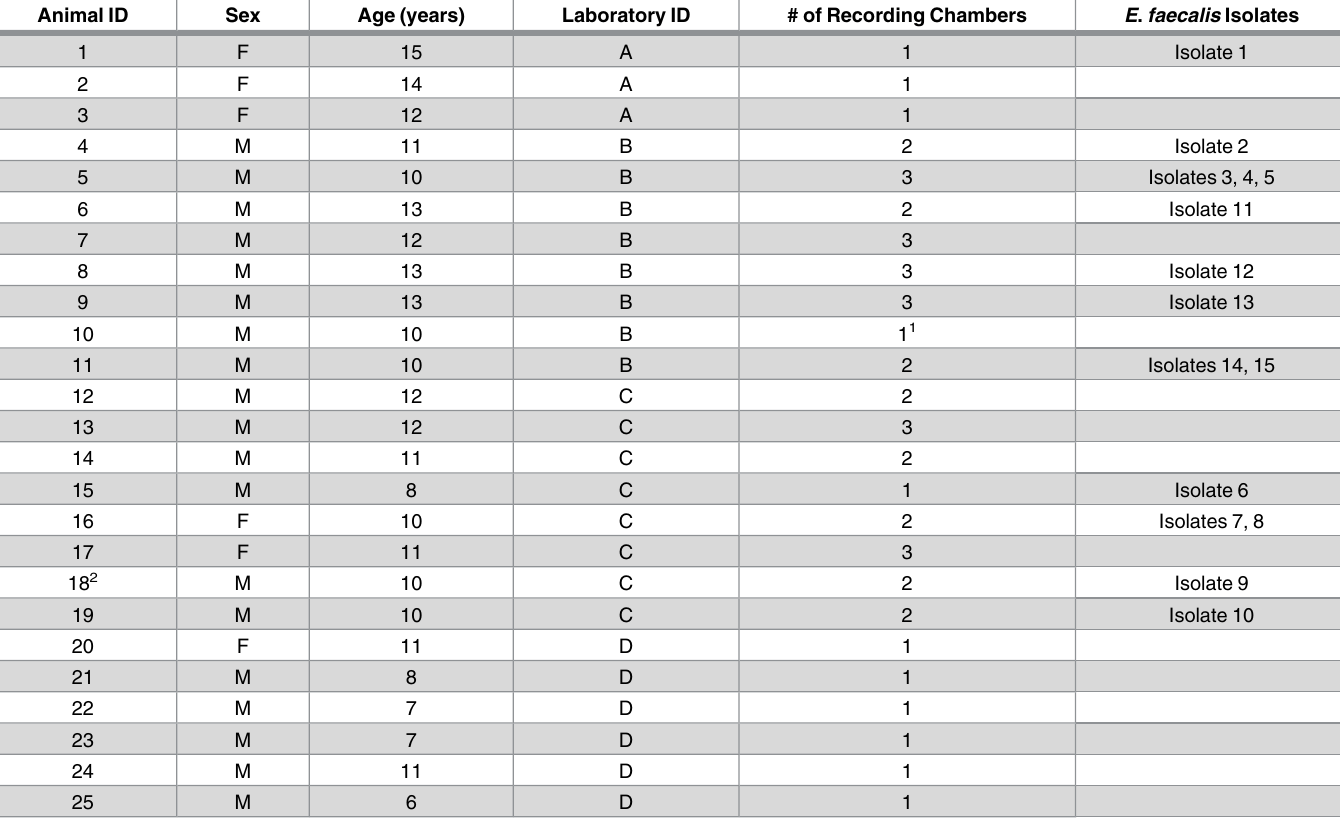
Table 1. Population Characteristics of Sampled ResearchMacaques. Animal